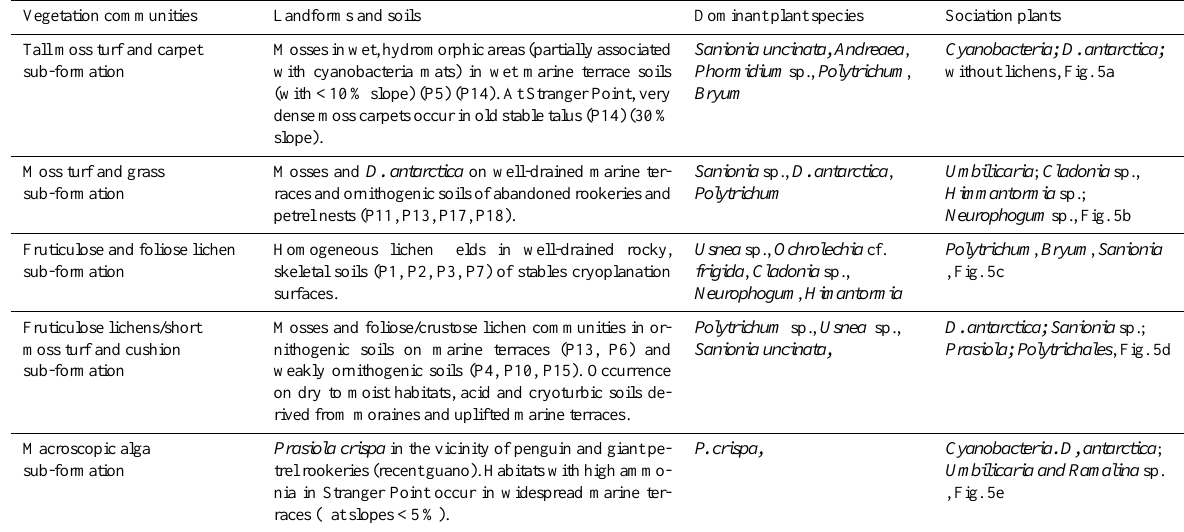
Table 1. Vegetation community classification of Potter Peninsula (adapted from Longton, 1988). Vegetation communities